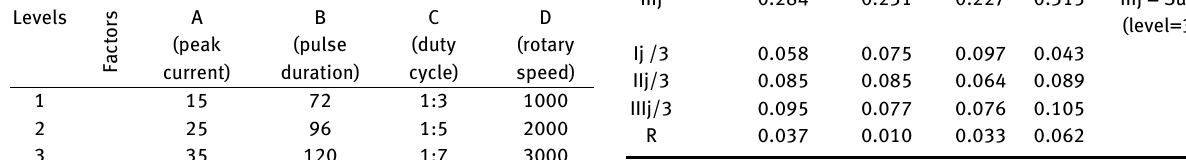
Table 2: Factors and levels for the orthogonal experimental study.